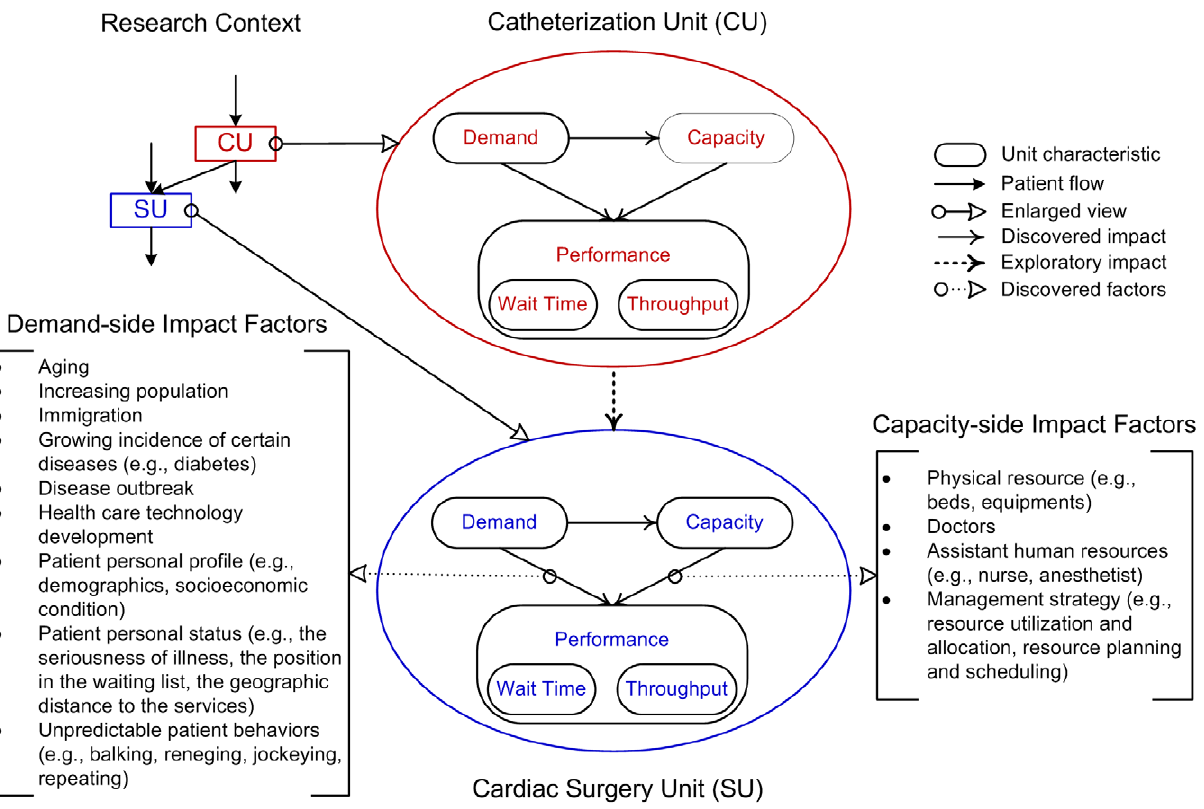
Figure 2. The research framework with the summarization of the impact factors for throughput and wait time.